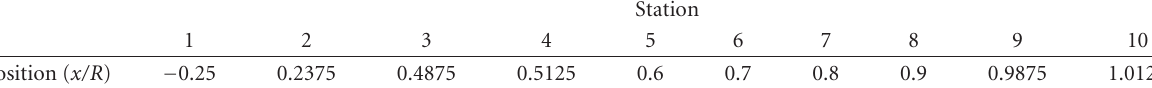
Figure 3: E ff ective measurement points. Table 1: Measurements stations.